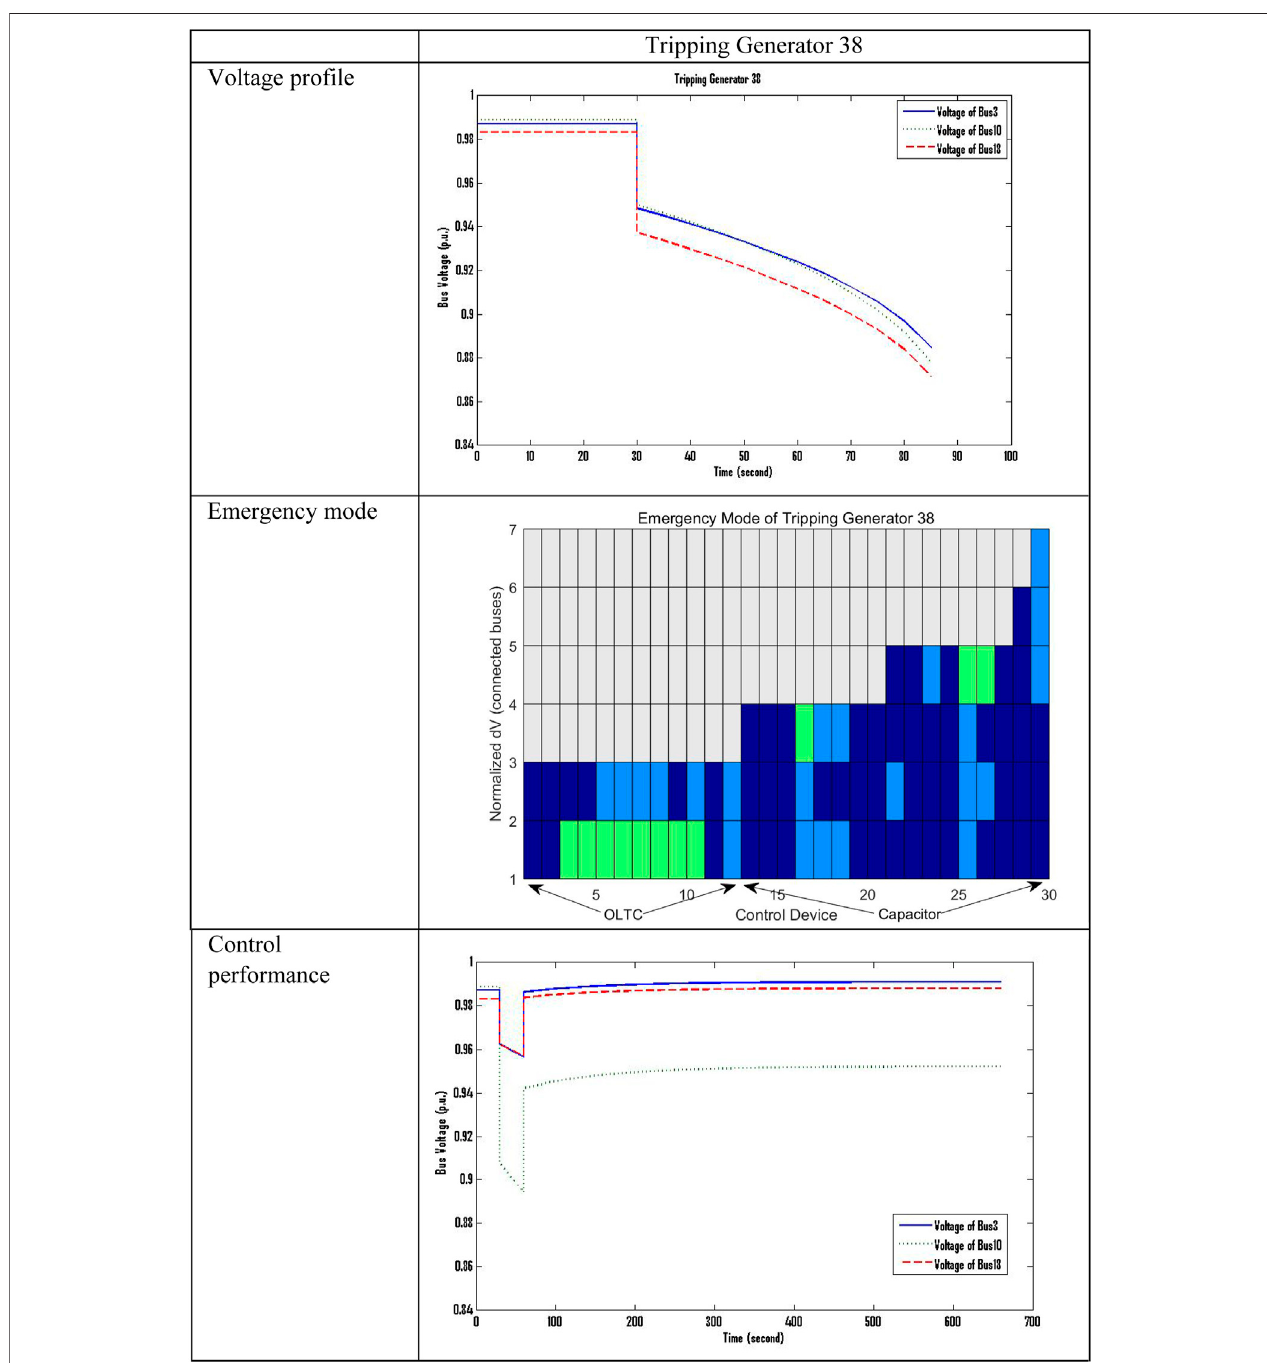
FIGURE 6 | Emergency control: Tripping Generator